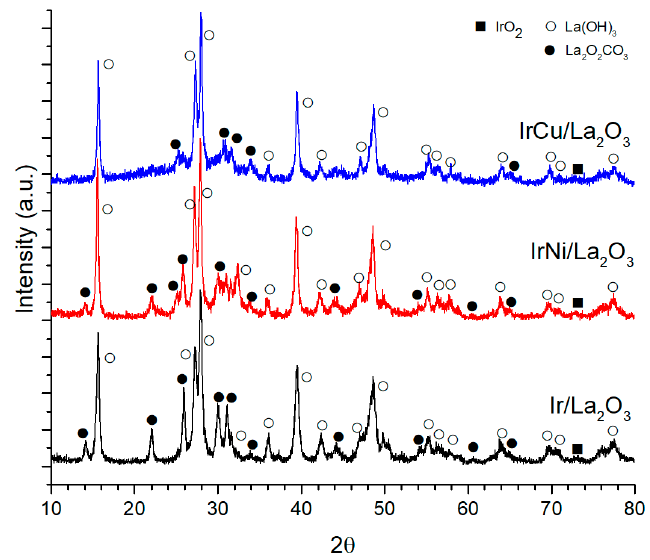
Figure 4. La 2 O 3 supported catalysts diffraction patterns.